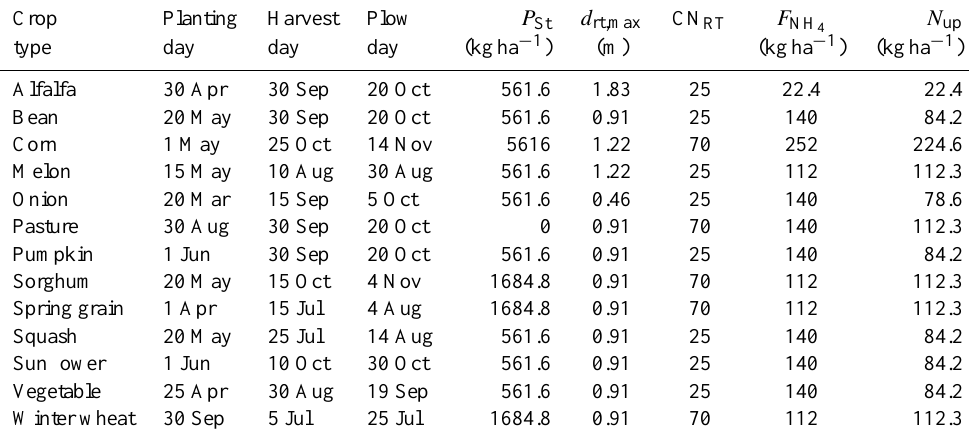
Table 1. Baseline agricultural management and crop parameter values for the model simulations. Crop Planting